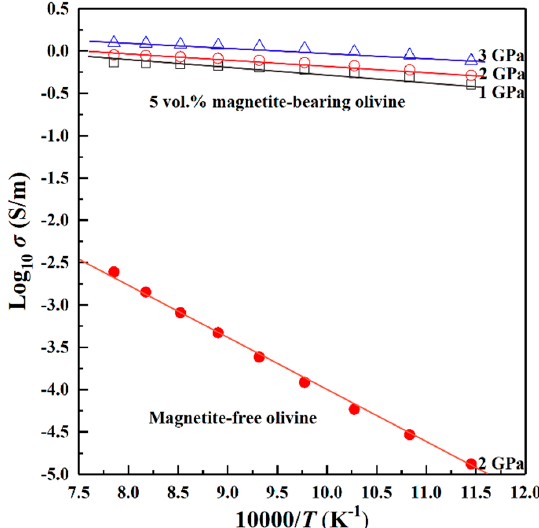
Figure 6. Influence of pressure on the electrical conductivity of 5 vol. % magnetite-bearing olivine aggregates in the temperature range of 873–1173 K. The electrical conductivity of the magnetite-free sample is presented for comparison at 2.0 GPa.